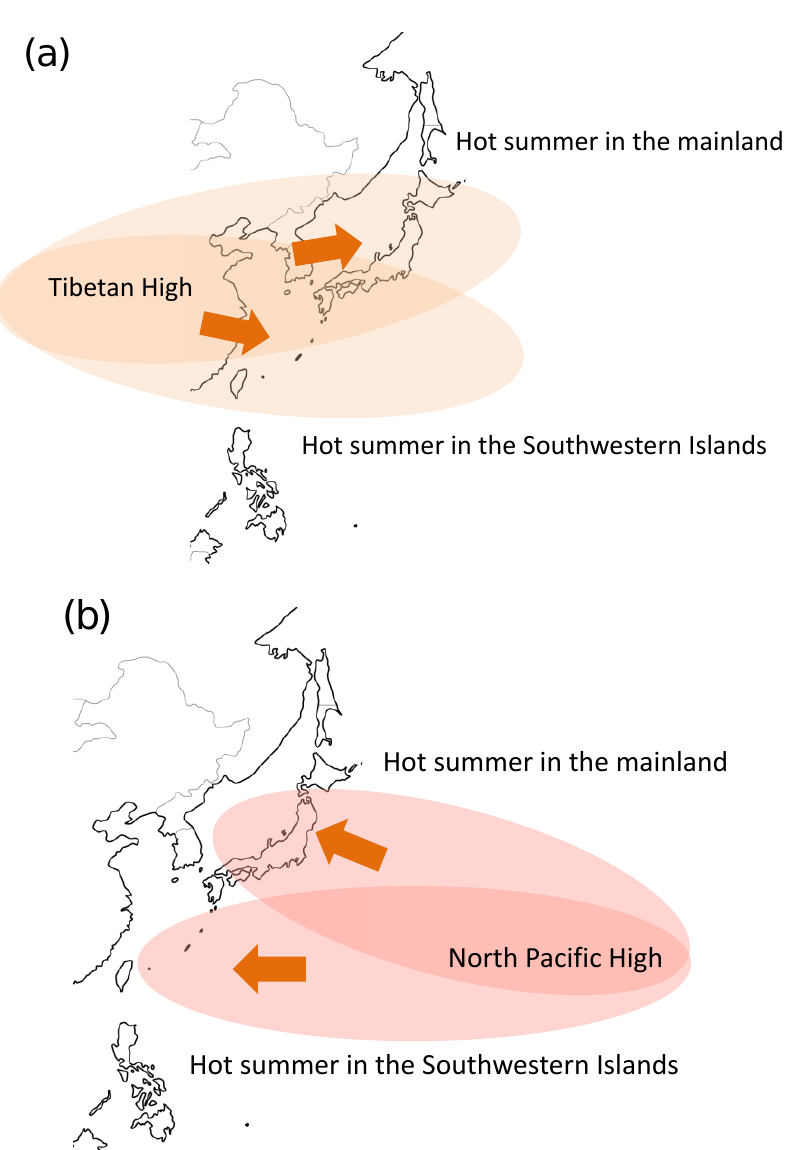
Figure 10. Schematic diagram showing the relationships between the latitudinal direction of exten- sion of ( a ) the Tibetan High and ( b ) the North Pacific High and the regions where hot summers occur in Japan.